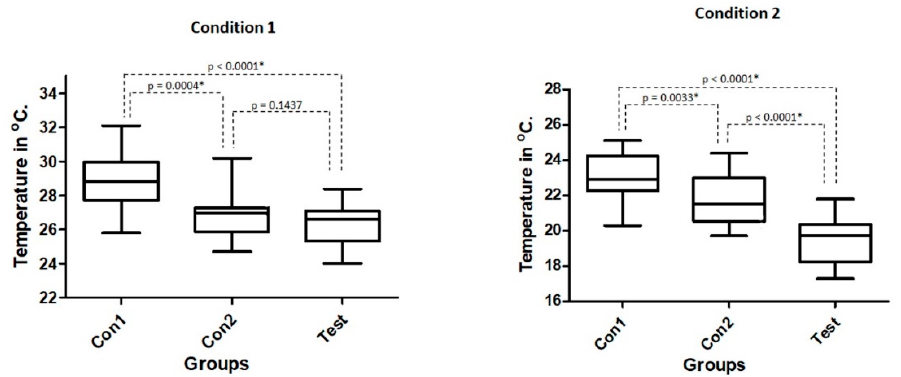
Figure 4. Box Plot graphs presenting the medians, quartiles and ranges of the 3 groups analyzed in both conditions tested (without and with irrigation, respectively) and the statistical comparison between the groups. *shows that they are statistically different.